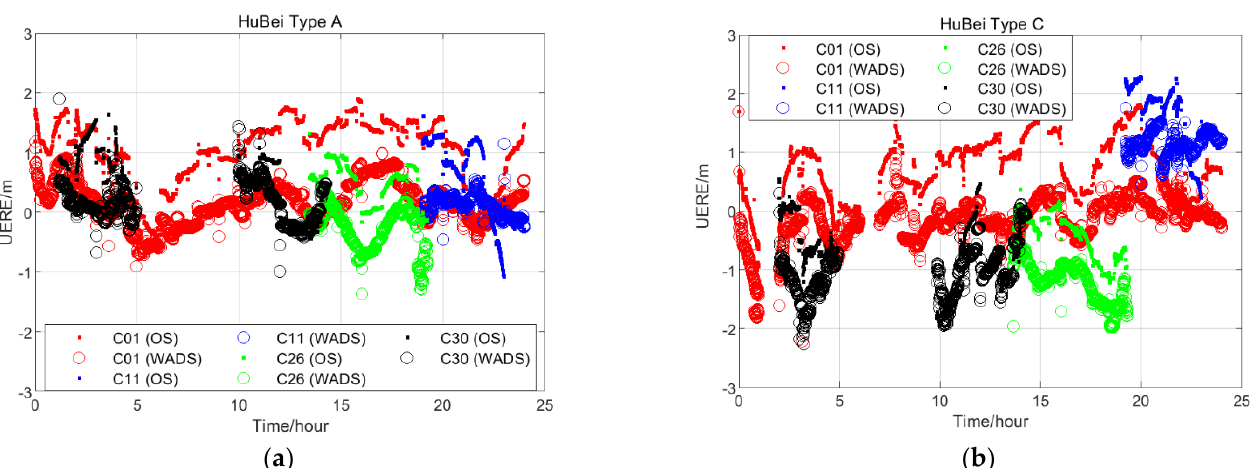
Figure 5. The UEREs calculated by a type A receiver and a type C receiver in the OS and the WADS: ( a ) the results of the type A receiver; ( b ) the results of the type C receiver.